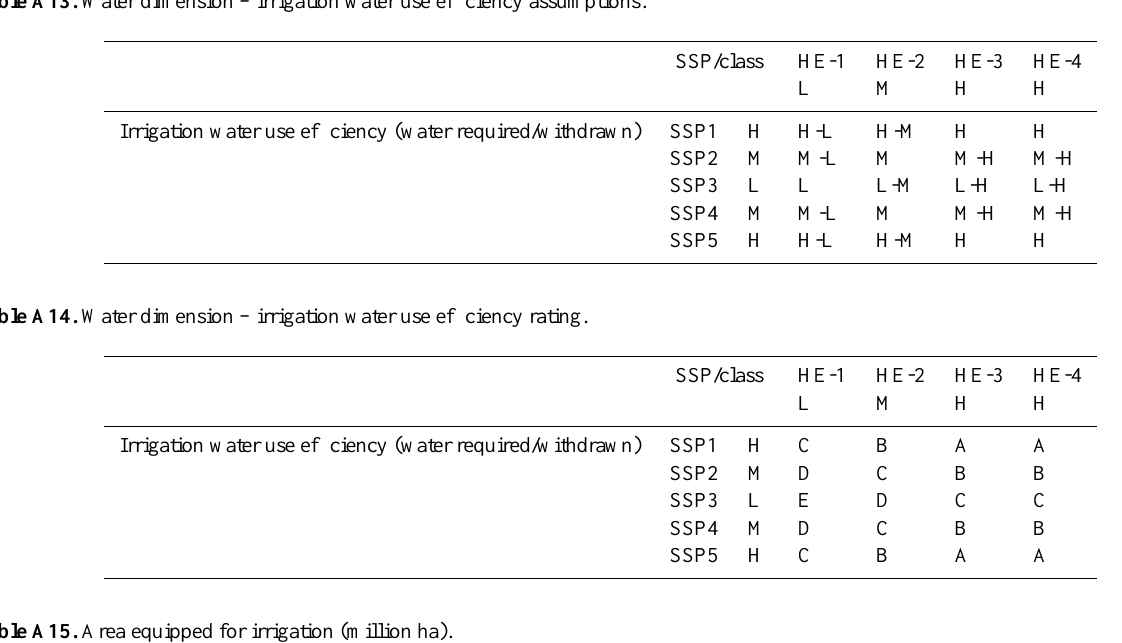
Table A15. Area equipped for irrigation (million ha).